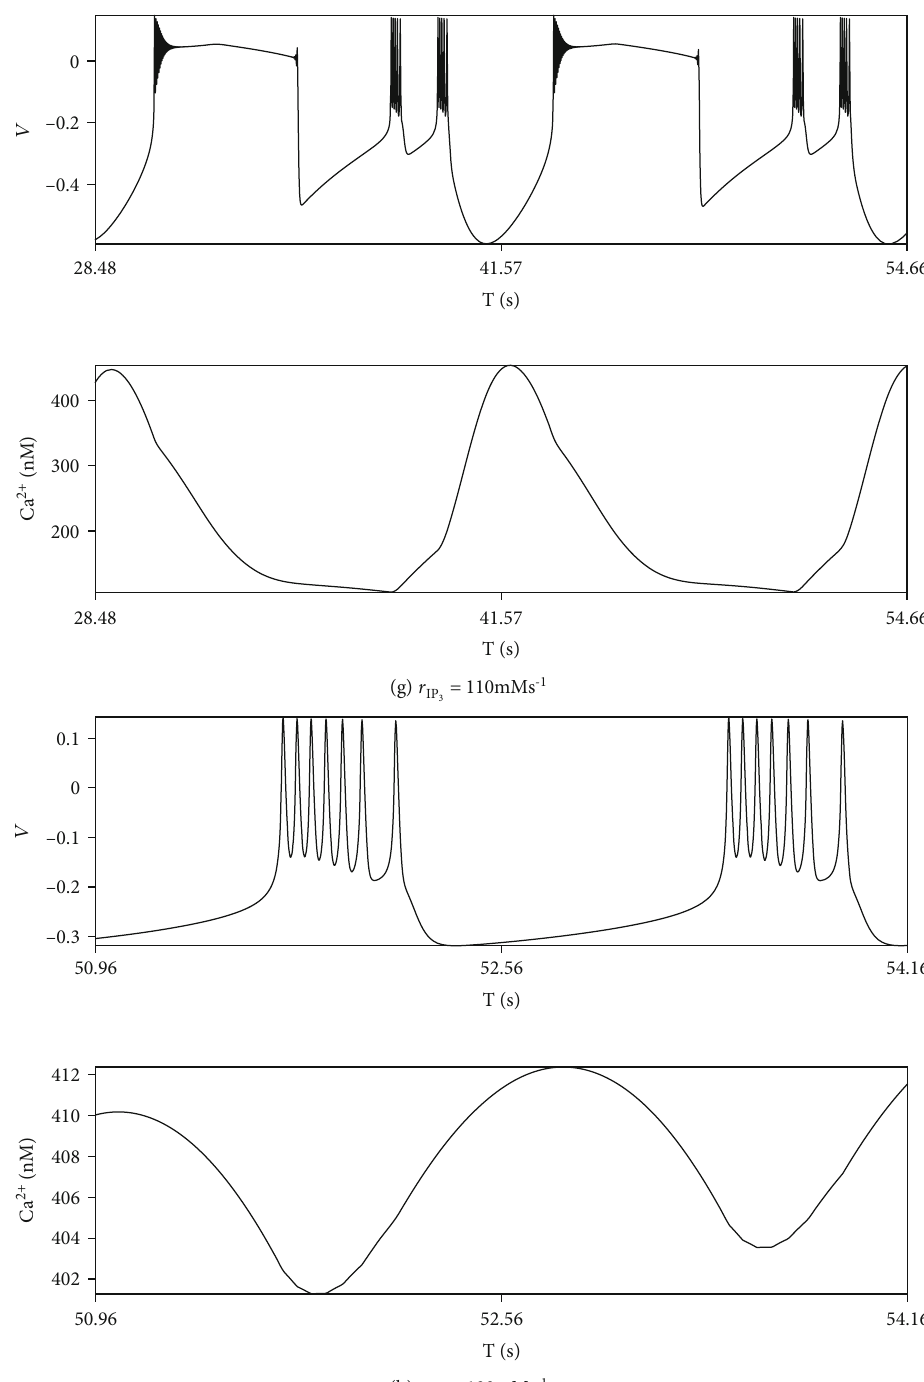
Figure 1: The neuron fi ring modes and Ca 2+ activities with no electromagnetic induction under di ff erent r